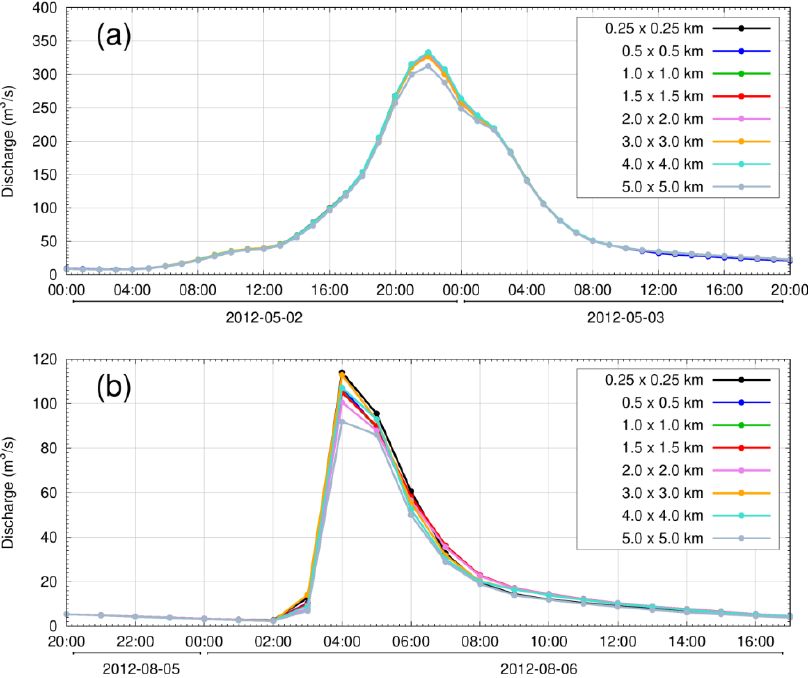
Figure 10. Time series profile of the simulated discharge at the outlet of the Tsurumi River Basin for the events of ( a ) 2–3 May 2012 (WR_N1), and ( b ) 5–6 August 2012 (CR_N1).